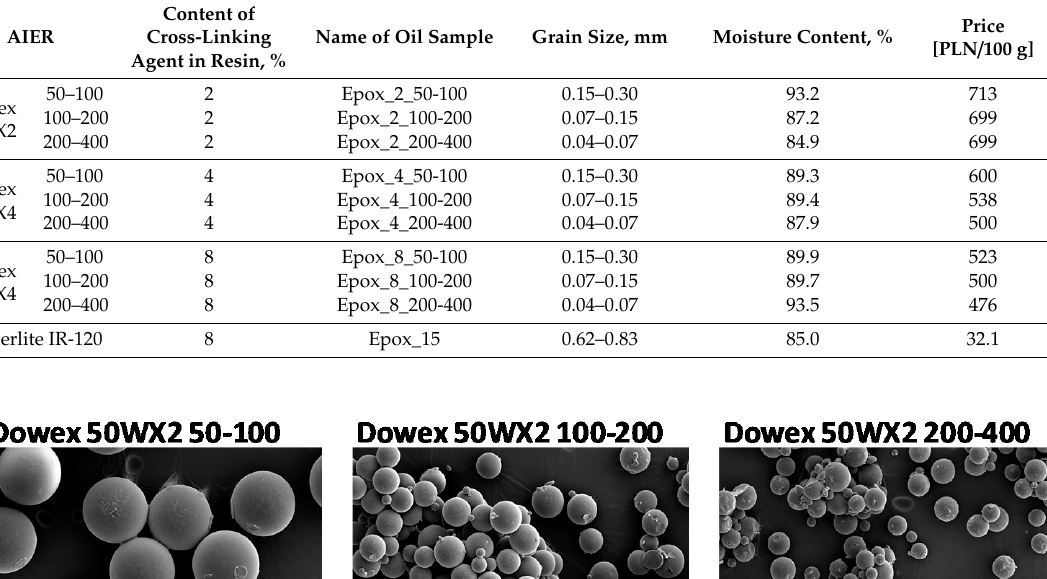
Table 2. Characteristics of acidic ion exchange resins (AIER).